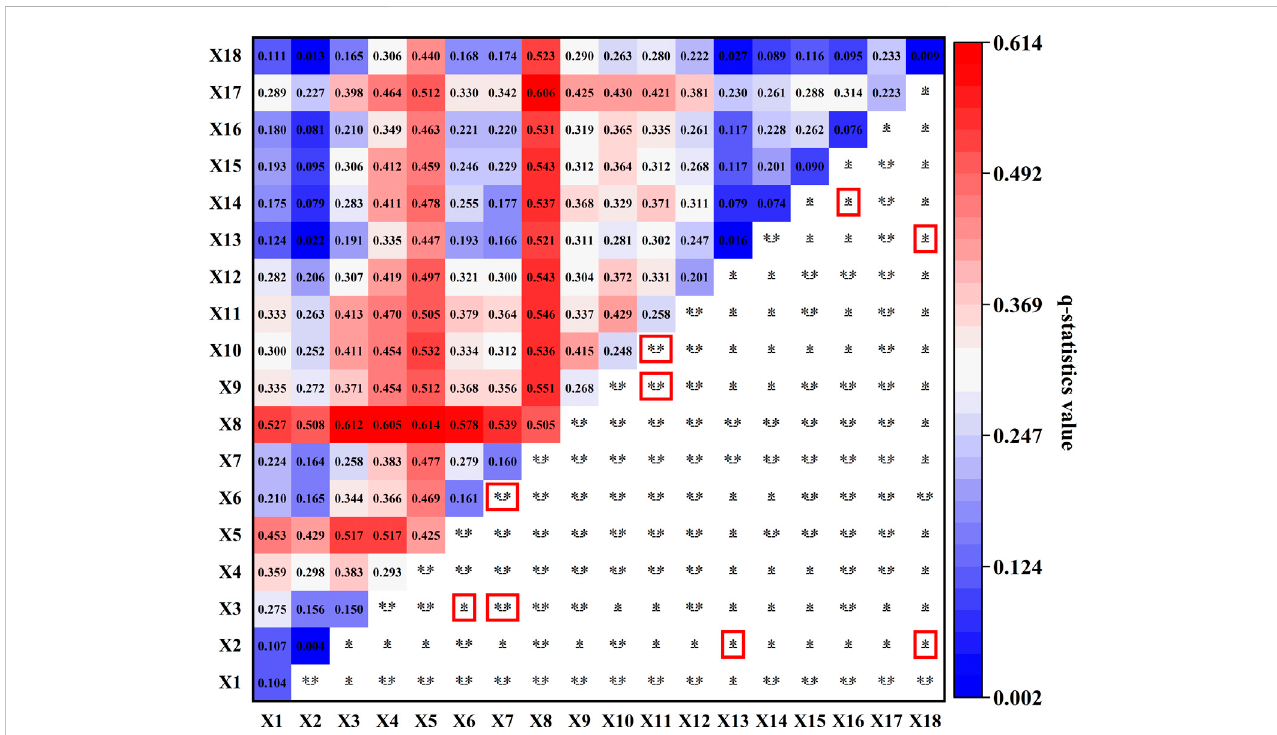
FIGURE 8 Interaction detection and ecological detection results. [Note: “ * ” and “ ** ” indicate non-linear and bivariate enhancements of two factors, respectively; the red boxes indicate the absence of signi fi cant differences between the two factors ( p < 0.05)].